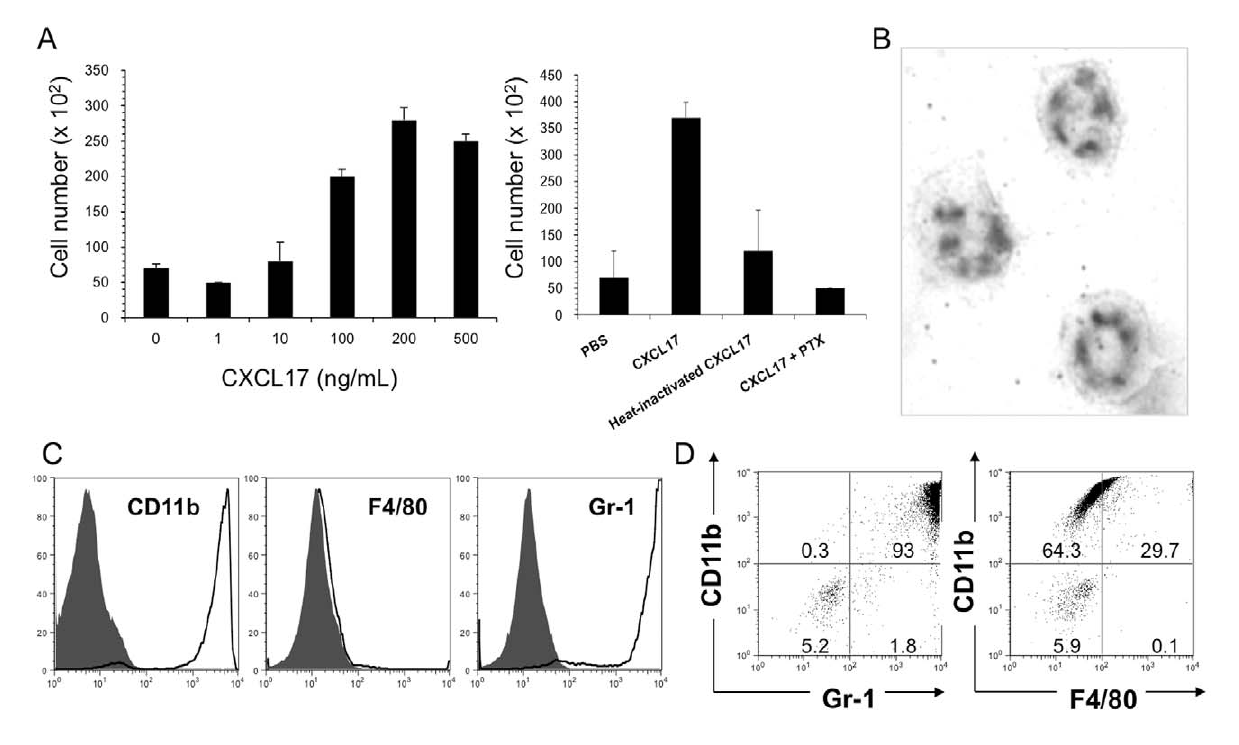
Figure 6. Characterization of CXCL17-responding cells invitro . (A) Spleen cells were isolated from SCID mice and used for the chemotaxis assay (see Materials and Methods ). Left panel, dose-dependent responses with recombinant CXCL17; right panel, chemotactic responses following various treatments. (B) Morphology of CXCL17-responding cells. CXCL17-responding cells were adhered onto a glass slide by centrifugation and then subjected to Wright-Giemsa staining. (C and D) Flow cytometric analysis of mouse CXCL17-responding cells (in the lower chamber of the chemotaxis assay). mCXCL17-responding cells were stained with PE-conjugated anti-mouse CD11b, FITC-conjugated anti-mouse F4/80 and FITC-conjugated anti- mouse Gr-1 mAbs, and then analyzed using flow cytometry. Shaded histograms represent staining with isotype-matched mAbs.